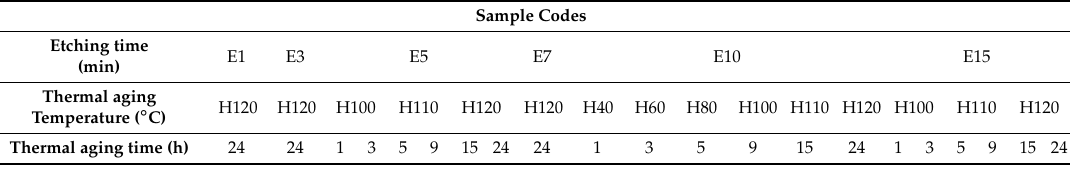
Figure 1. Schematic of the plasma etching and thermal aging process to develop a superhydrophobic PP fabric. Table 1. Sample codes during the